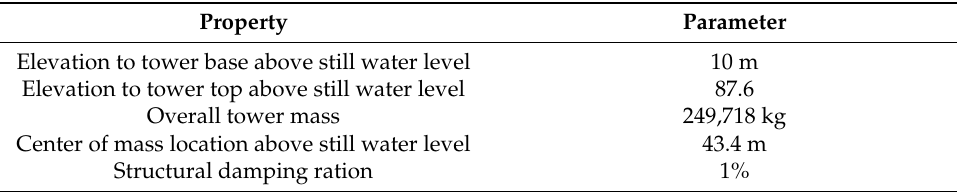
Table 6. Undistributed tower properties.